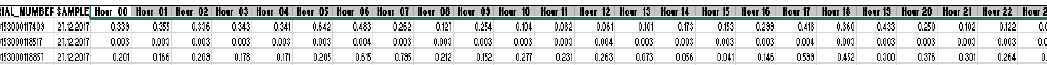
Figure 4. The input data sequence of the algorithm.